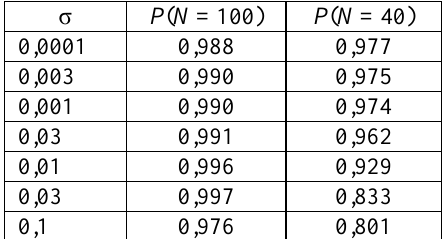
Table 2. Empirical probability of finding the correct line in N = 100 and 40 points with 80 % outliers using 169 samples